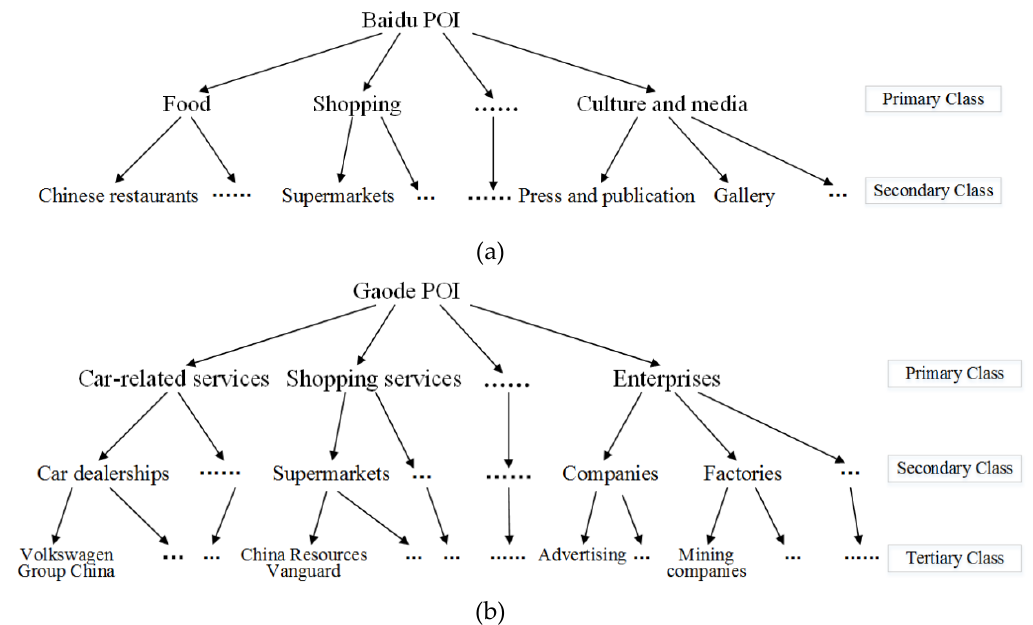
Figure 6. POI class categories of Baidu Map ( a ) and Gaode Map ( b ).